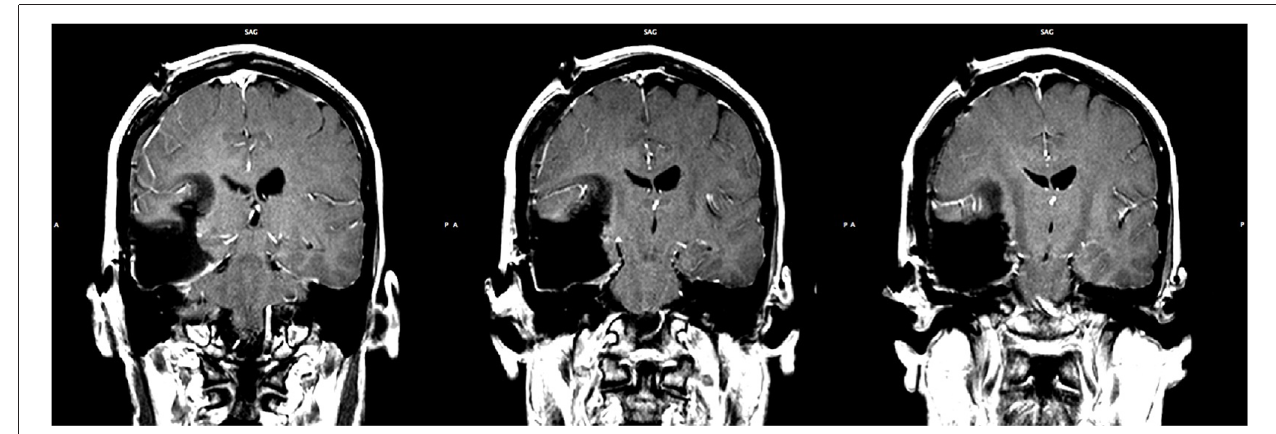
FIGURE 5 | Post-operative MRI showing the extent of resection. Gross total resection was achieved (slice indices are approximately y = − 28, y = − 29, y = − 30, from left to right